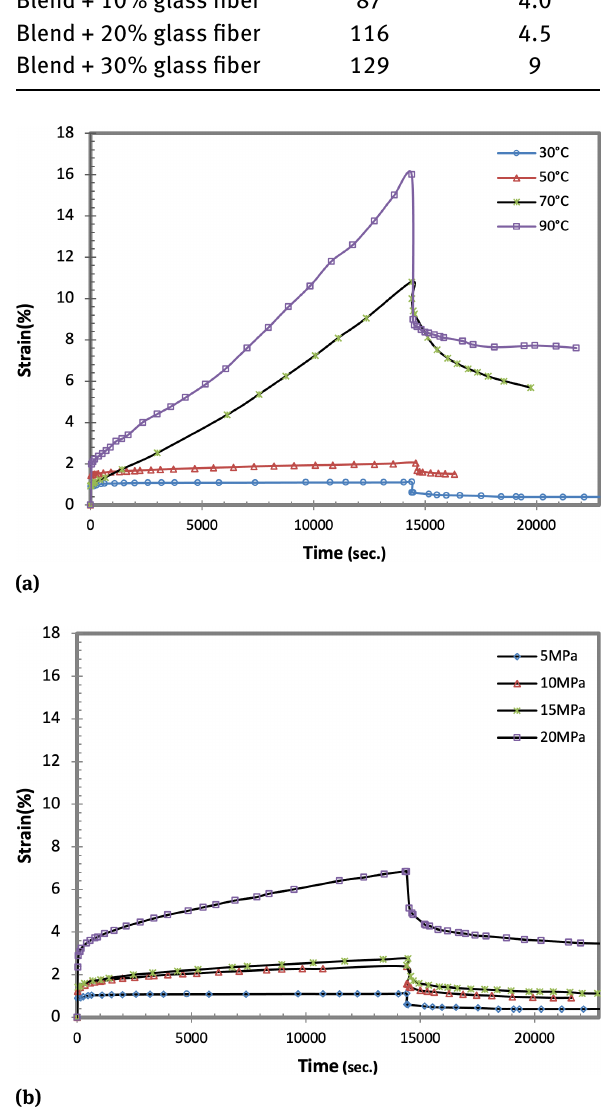
Figure 1: Creep and creep recovery behavior of epoxy (a) 5 MPa at different temperatures (b) Different applied stresses at 30 ∘